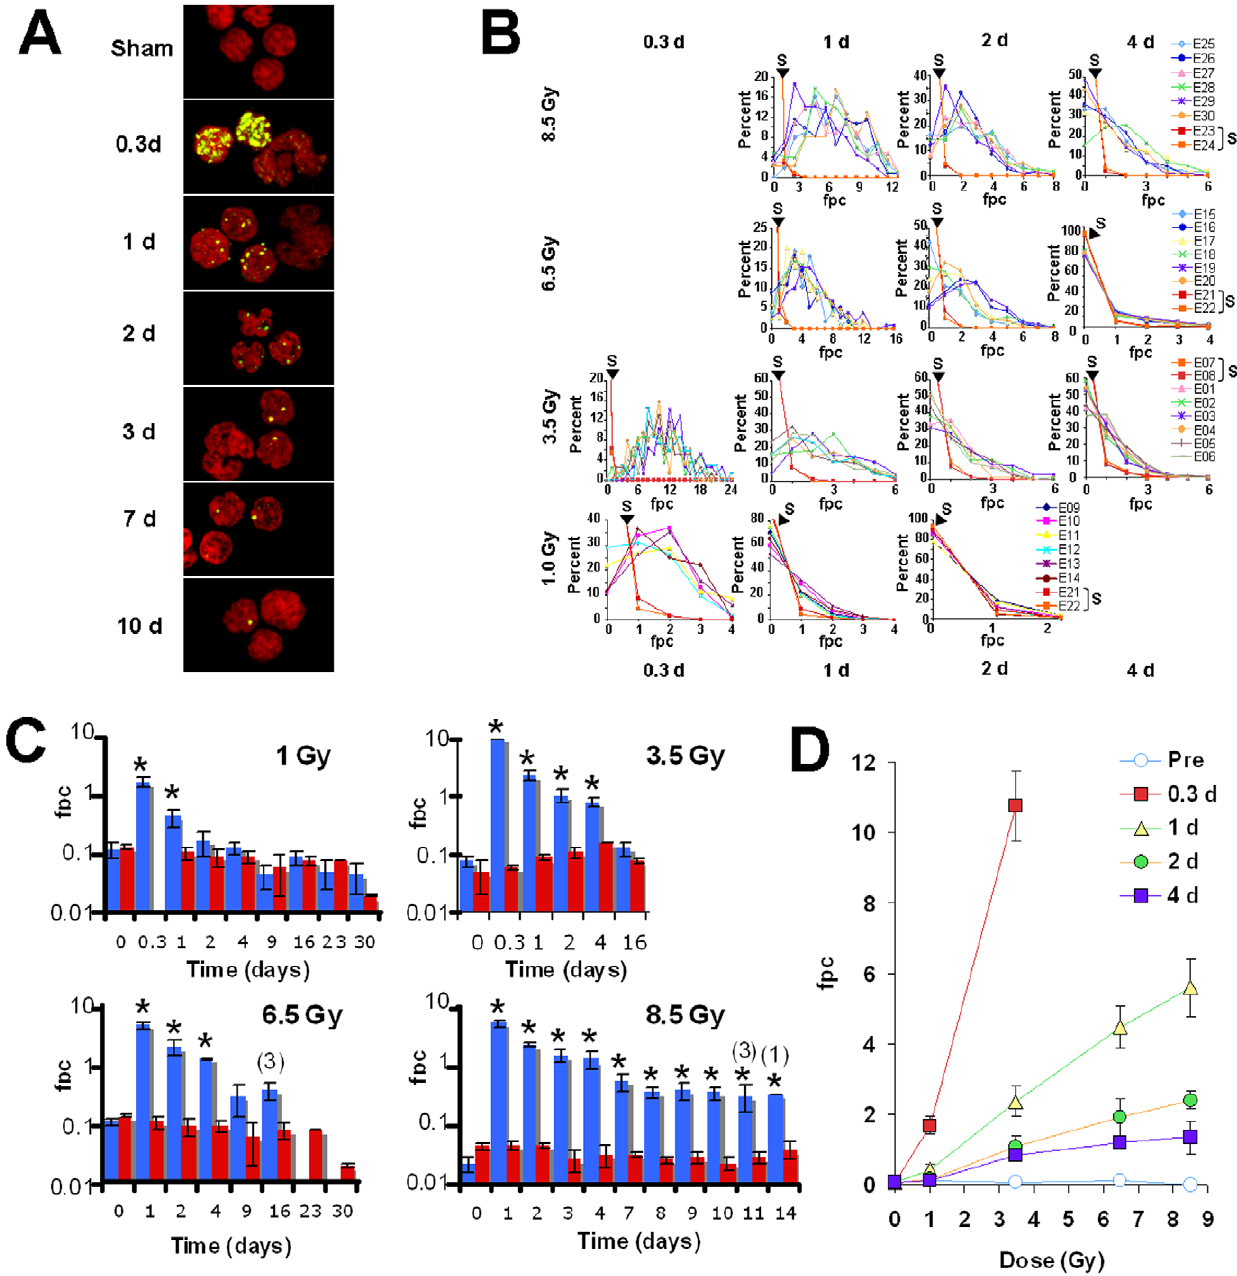
Figure 2. Kinetics for c -H2AX foci loss in macaque lymphocytes after total body irradiation. ( A ) Representative images of macaque lymphocytes in Sham-irradiated (Sham) and 0.3, 1, 2, 3, 7 and 10 days (d) after 8.5 Gy-TBI. As previously observed with blood samples irradiated ex- vivo , the c -H2AX foci were fewer and fainter in neutrophils than in lymphocytes. Green, c -H2AX; red, DNA stained with PI. Arrowheads indicate neutrophils. ( B ) c -H2AX foci distribution in lymphocytes taken from individual animals subjected to TBI. The rows from top to bottom show the focal distributions from individual animals after 8.5 Gy-TBI (6 macaques E25 to E30) and Sham-TBI (2 macaques E23 and E24, noted S), 6.5 Gy-TBI (6 macaques E15 toE20) and Sham-TBI (2 macaques E21 and E22, noted S), 3.5 Gy-TBI (6 macaques E01to E06) and Sham-TBI (2 macaques E07and E08, noted S), and 1 Gy-TBI (6 macaques E09 to E14) and sham-TBI (2 macaques E21 and E22, noted S). Results from the sham-IR are shown with red lines (noted S). The columns from left to right correspond to the different sampling times post-TBI, 0.3 d (1 and 3.5 Gy), 1 d (1 , 3.5 , 6.5 and 8.5 Gy), 2 d (1 , 3.5 , 6.5 and 8.5 Gy), and 4 d (3.5 , 6.5 and 8.5 Gy). ( C ) Values for c -H2AX foci per cell vs days after the indicated TBI doses. The data for the TBI treated cohorts (blue bars) and sham treated controls for each cohort (red bars) are plotted on a log scale to bring out the details concerning differences between the TBI and sham treated animals. The data are shown as mean numbers of c -H2AX foci per lymphocyte from each cohort 6 standard deviations (n=2 for Sham irradiated samples; n=6 for TBI-irradiation, except 16 days after 3.5 Gy, n=3 and 11 days after 8.5 Gy; no SD was determined 14 days after 8.5 Gy as data were prepared from 1 animal). ( D ) Foci per cell values in lymphocytes taken at the noted time (Pre=the day before TBI) and plotted vs TBI dose. Data are means 6 standard deviations (n=6). Equations for trendlines and R-squared values are y= 2 0.005x + 0.096 / R 2 =0.225 for Pre-IR; y=3.167x 2 0.578 / R 2 =0.980 for 0.3 d; y=0.672x 2 0.034 / R 2 =0.996 for 1 d; y=0.286x + 0.014 / R 2 =0.993 for 2 d and y=0.158x + 0.097 / R 2 =0.956 for 4 d. Asterisks in ( C ) denote statistically difference between TBI-and sham-irradiated macaques (P , 0.05, t-test). Detailed statistical analysis is shown in Table 2 . Numbers in ( C ) for the 6.5 and 8.5 Gy panels correspond to the numbers of animals alive after TBI at the indicated time (no number indicates that all 6 TBI-irradiated animals are alive).